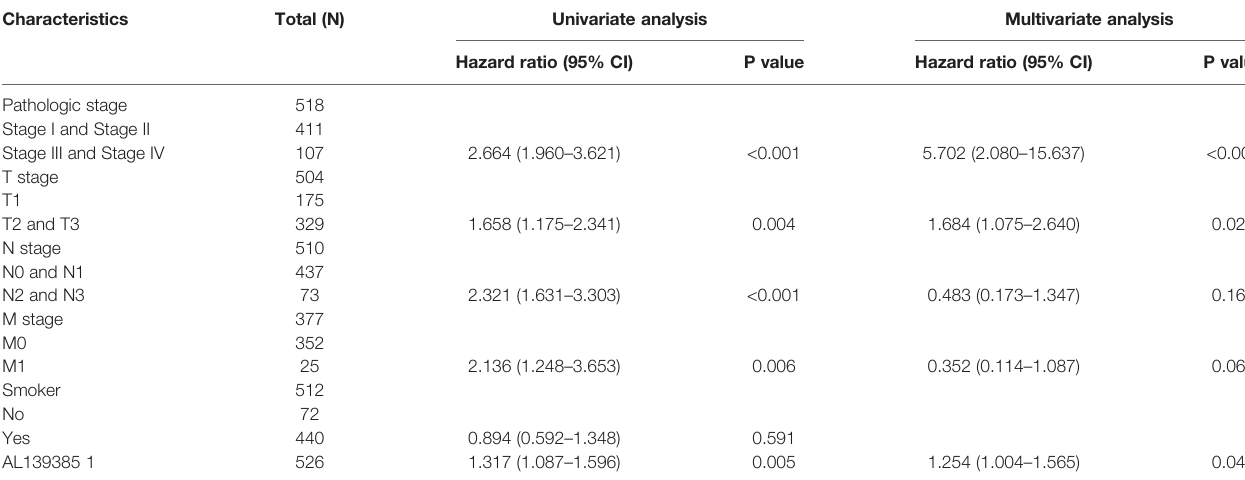
TABLE 1 | Univariate and multivariate Cox regression analyses of different parameters on overall survival in lung adenocarcinoma. Characteristics